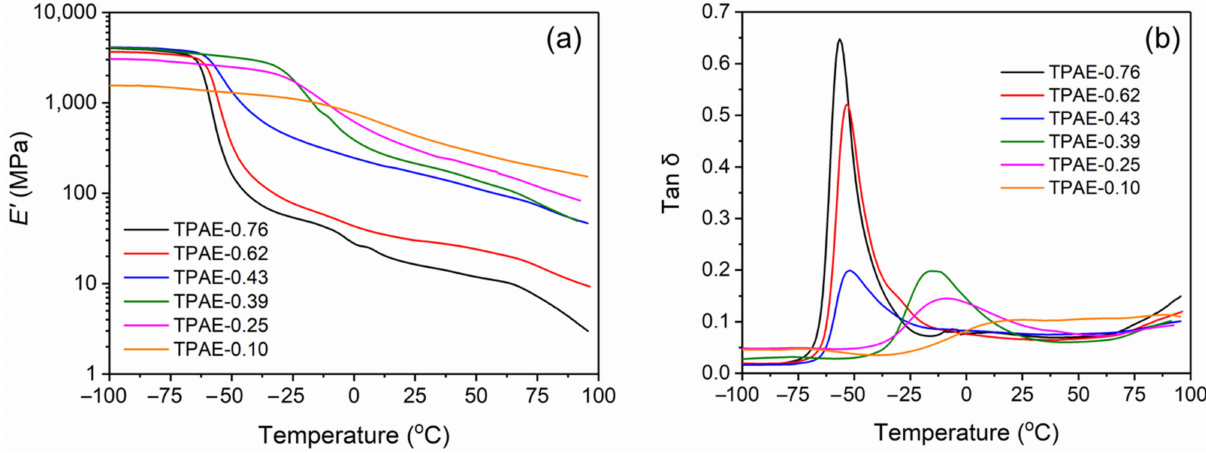
Figure 9. Thermomechanical analysis of TPAEs: ( a ) storage modulus ( E ’) vs. temperature and ( b ) loss factor ( tan δ ) vs.